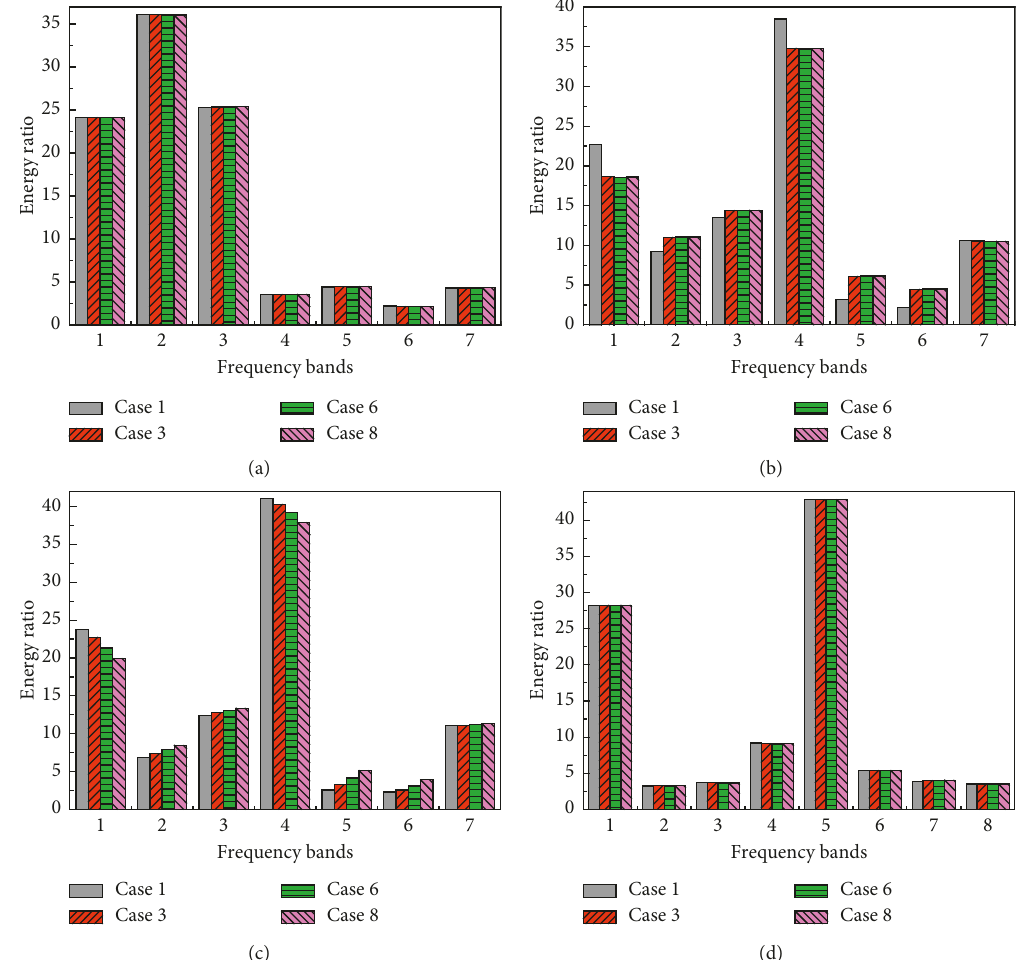
Figure 14: Hilbert feature vector spectrum in model tests (two damages). (a) Point 1. (b) Point 12. (c) Point 14. (d) Point